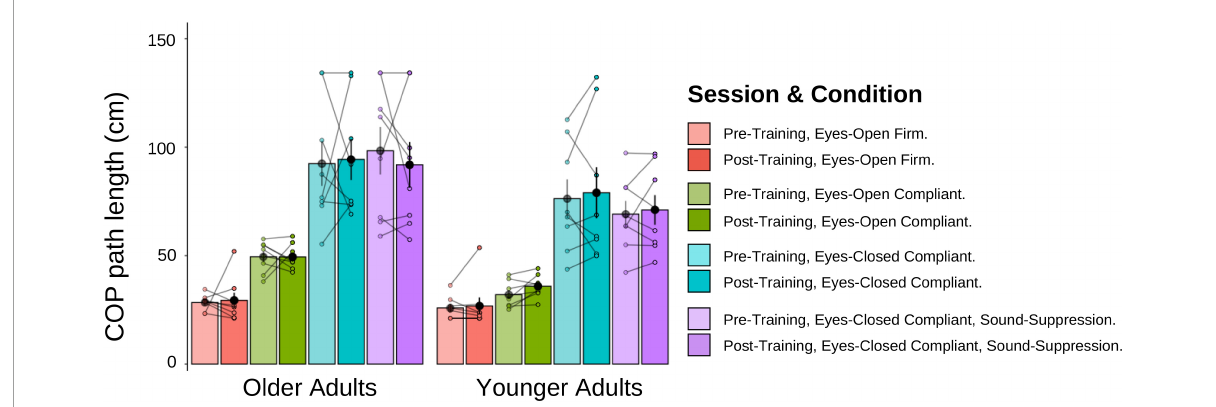
FIGURE11 Mean COP path length (cm) for older and younger adults, pre-training (lighter shades) and post-training (darker shades). The individual data points are plotted for all four posturography conditions, with lines connecting each participant’s pre-training COP path length to their post-training COP path length. Black dots represent means, plotted with standard error